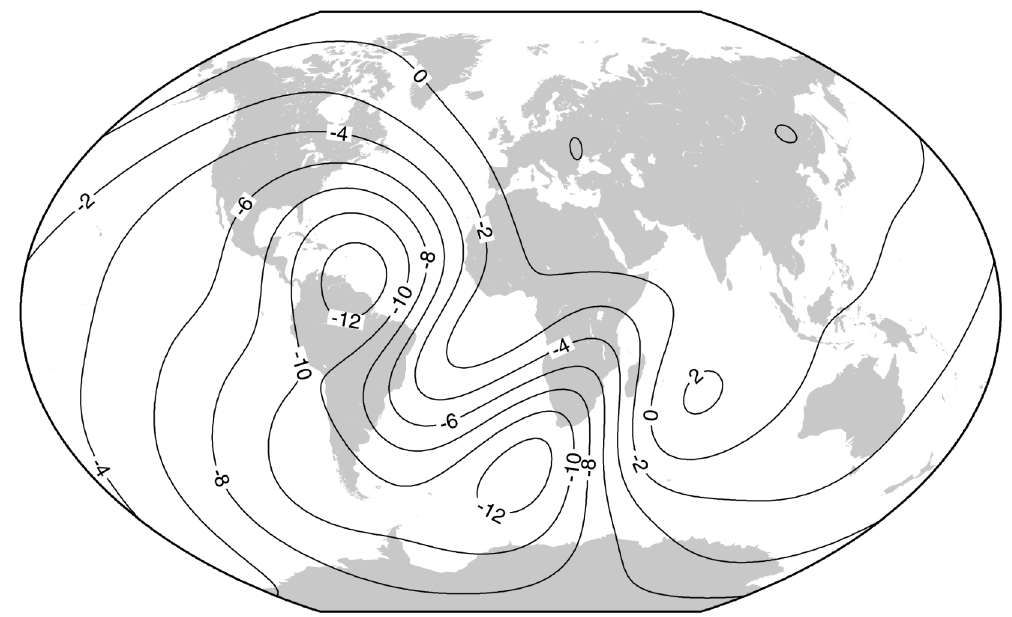
Fig. 3. Change in magnetic field strength 1955.0-2005.0 as percentage of mean field for same period, from